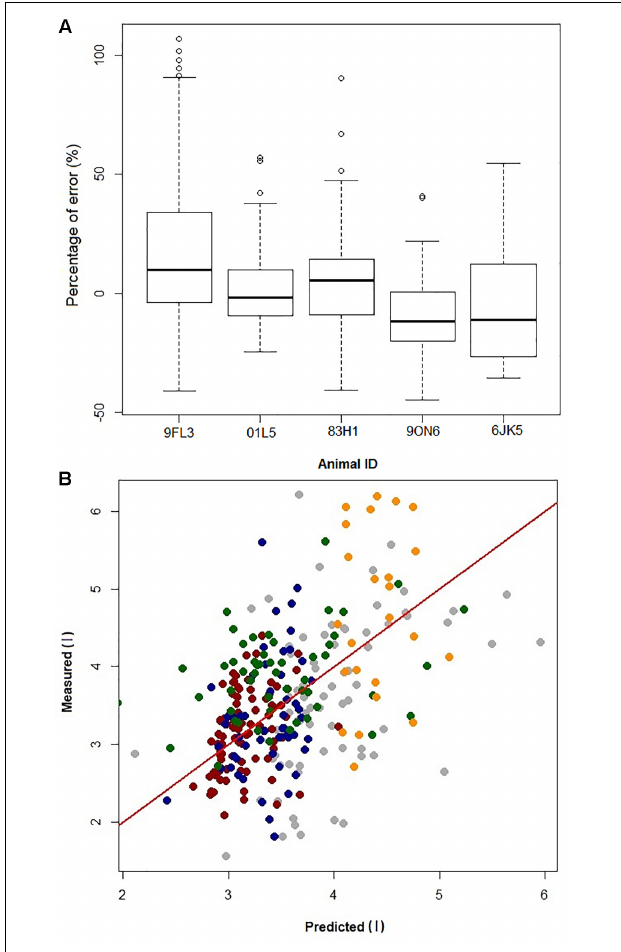
FIGURE 4 | (A) Boxplot of prediction error [error = (predicted–measured) / measured × 100] from jackknife sensitivity analysis, where the data from one dolphin (Animal ID) is removed to generate the GAMs and the resulting GAMs model is used to predict V Tinsp for that dolphin. (B) Plot of error in prediction of a single dolphin V T when building the GAM using data from the other four dolphins. Gray = 9FL3; Red = 01L5; Blue = 83H1; Green = 9ON6; Orange = 6JK5; Red line is identity